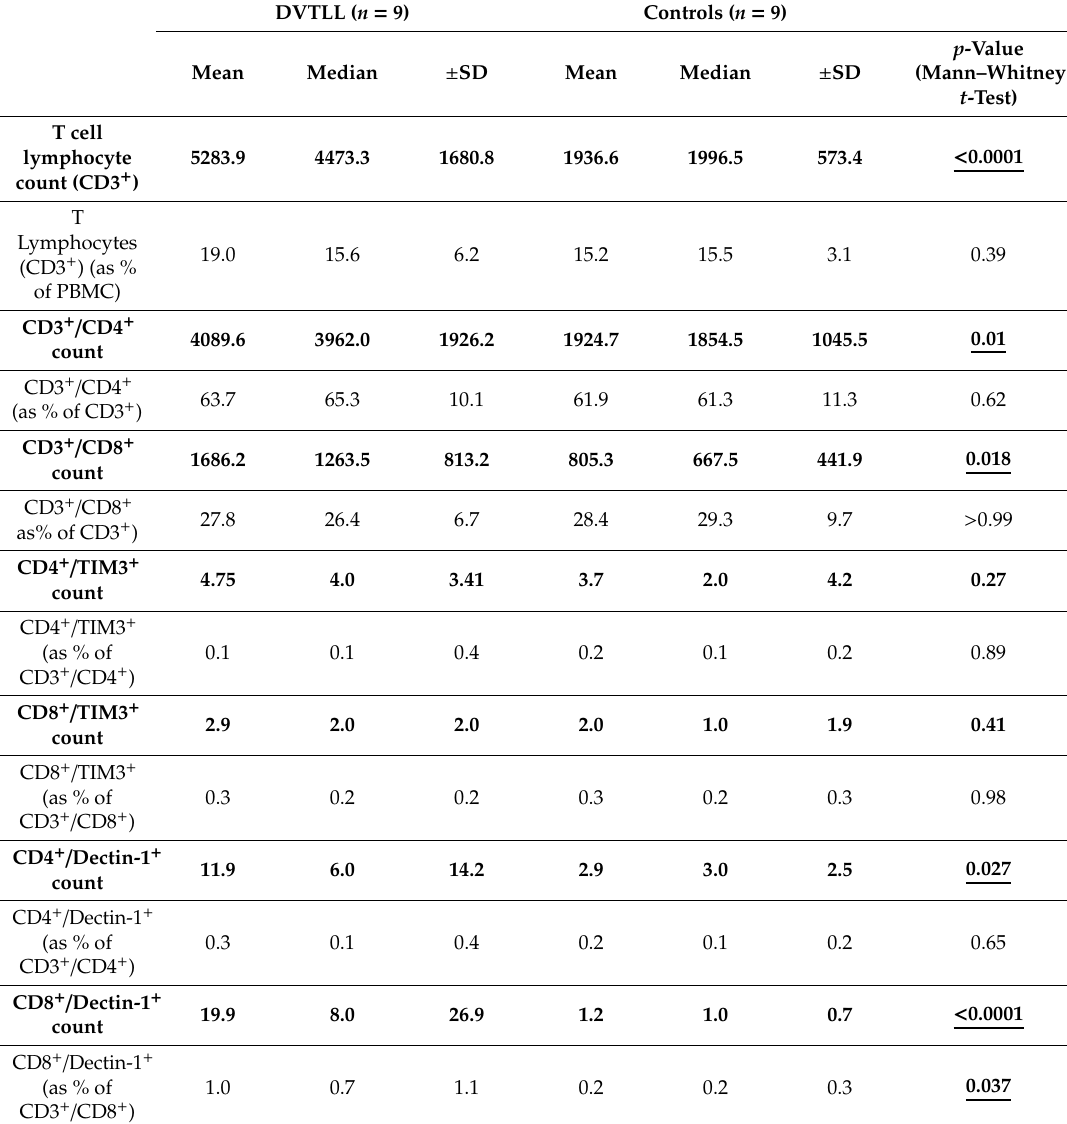
subpopulations calculated with respect to each category in DVTLL patients and in health controls are reported as mean and median. Statistical analysis for DVTLL patients compared to controls was performed by a Mann–Whitney test. Statistically significant values ( p < 0.05) are